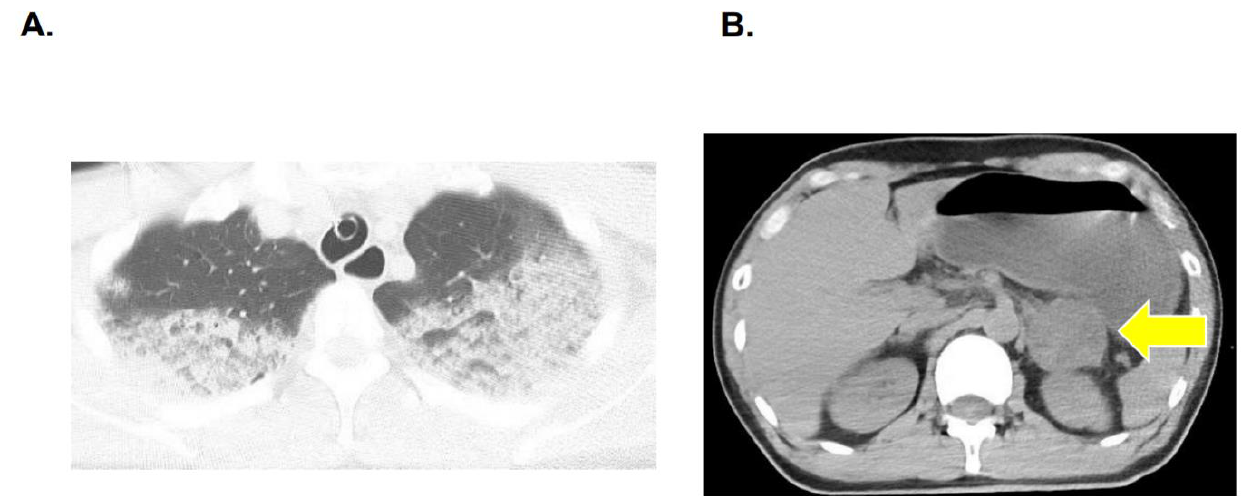
Figure 2. Chest computed tomography showing bilateral pulmonary infiltration ( A ). Abdominal computed tomography showing a nodule on the left adrenal gland (a yellow arrow) ( B ).